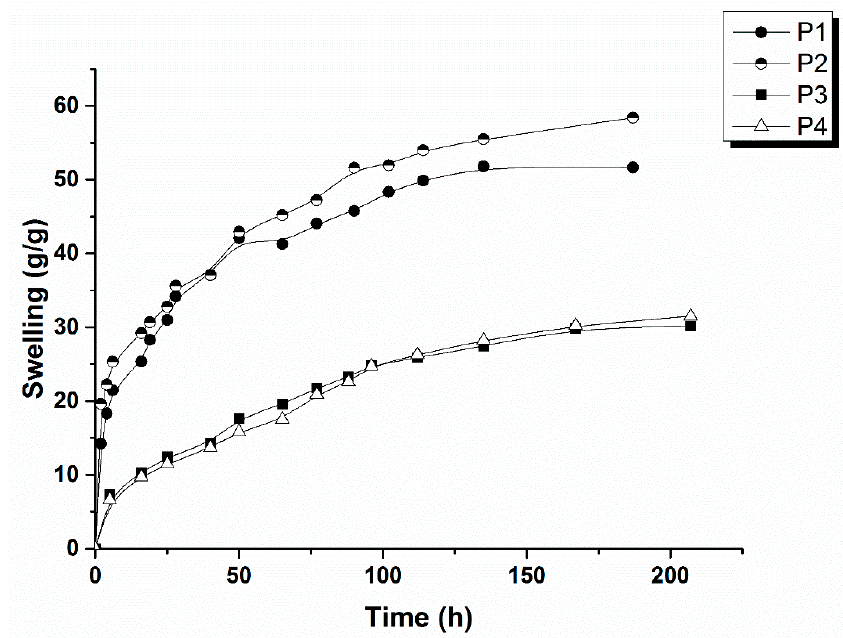
Figure 6. Swelling ratio of the studied samples: P1–P4.